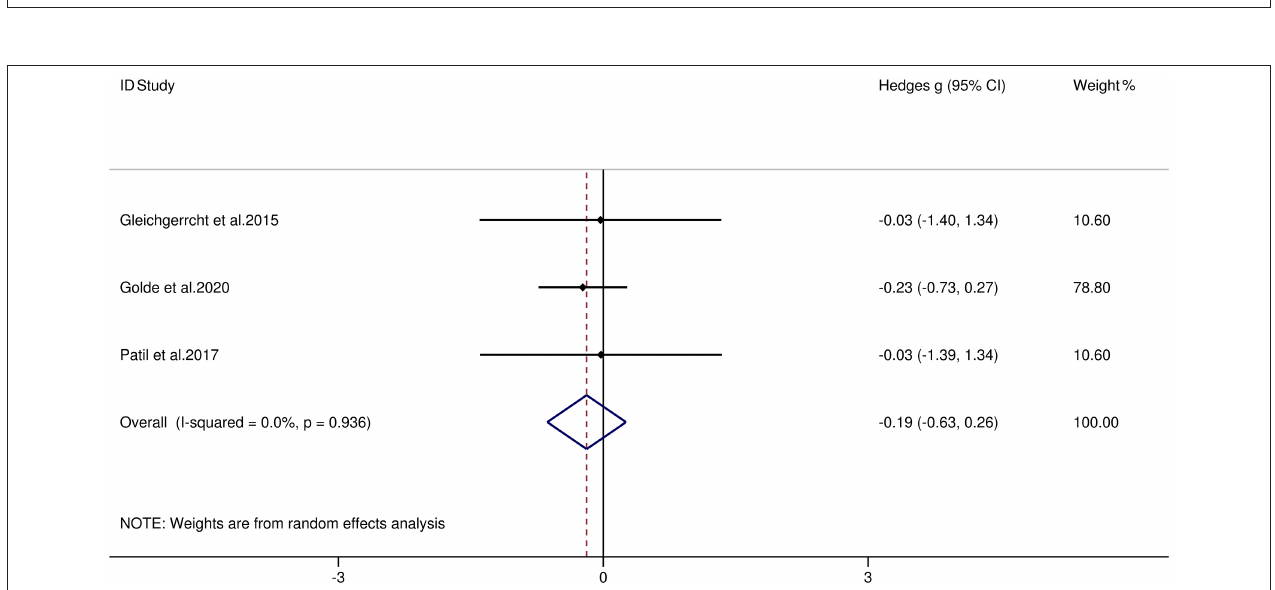
FIGURE 6 | Forest plots showing effect size estimates (Hedges g) for affective empathy differences between MS and healthy controls. CI, confidence interval; MS, multiple sclerosis; ToM, theory of mind.